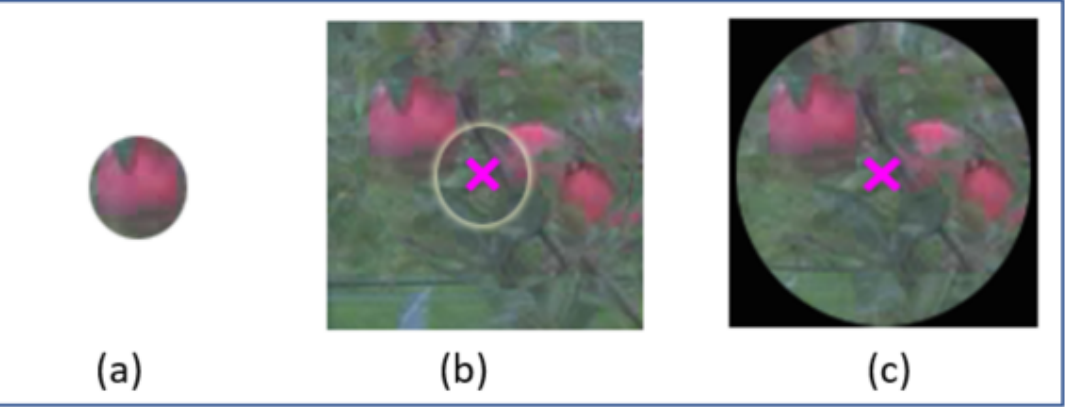
Figure 5. Construction of attention areas. ( a ) The average diameter of an average apple is 30 pixels in our dataset; ( b ) a cross indicates the center of the gaze of the annotator. There is a shift error from the apple of ( a ). The maximum distance of the gazing point with the center of the closest object was found at 169 pixels. ( c ) Chosen attention area with a size of 180 × 180 pixels.